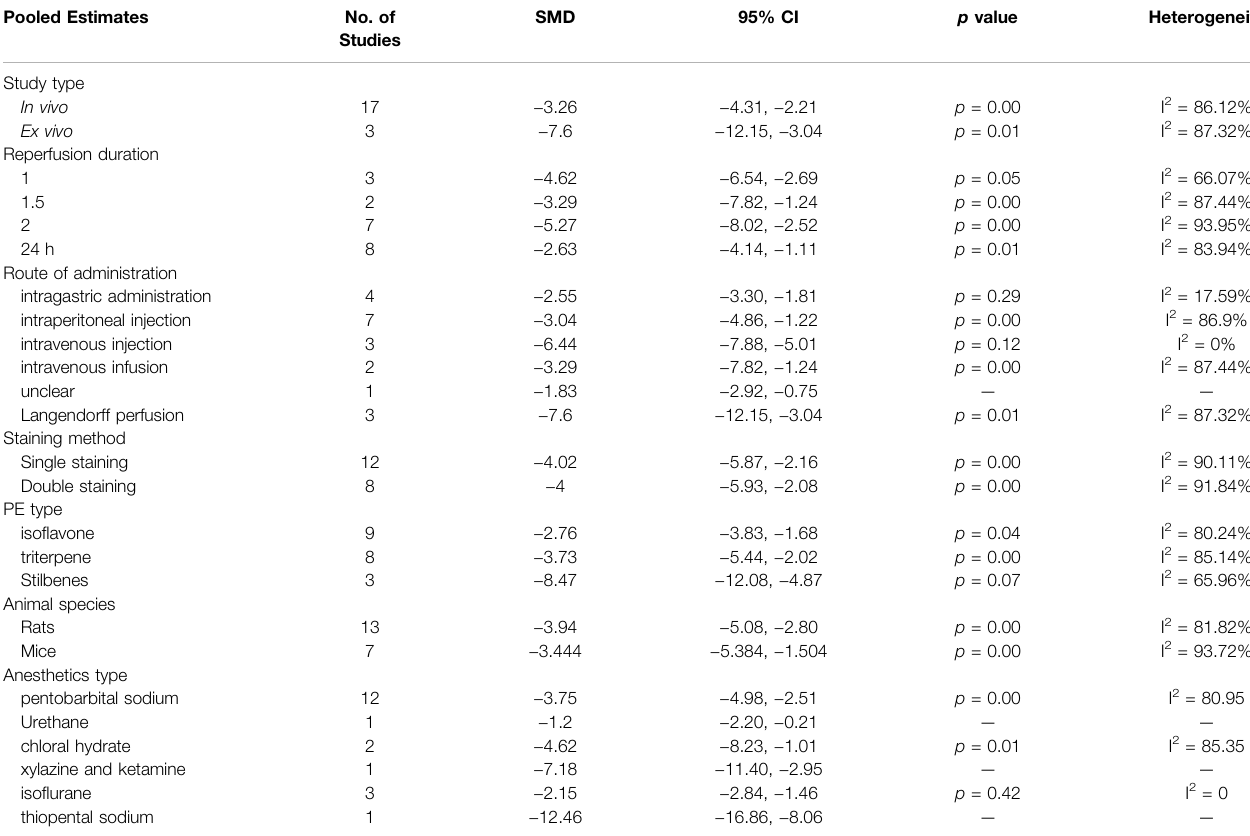
TABLE 4 | Strati fi ed analysis of pooled estimates of infarct